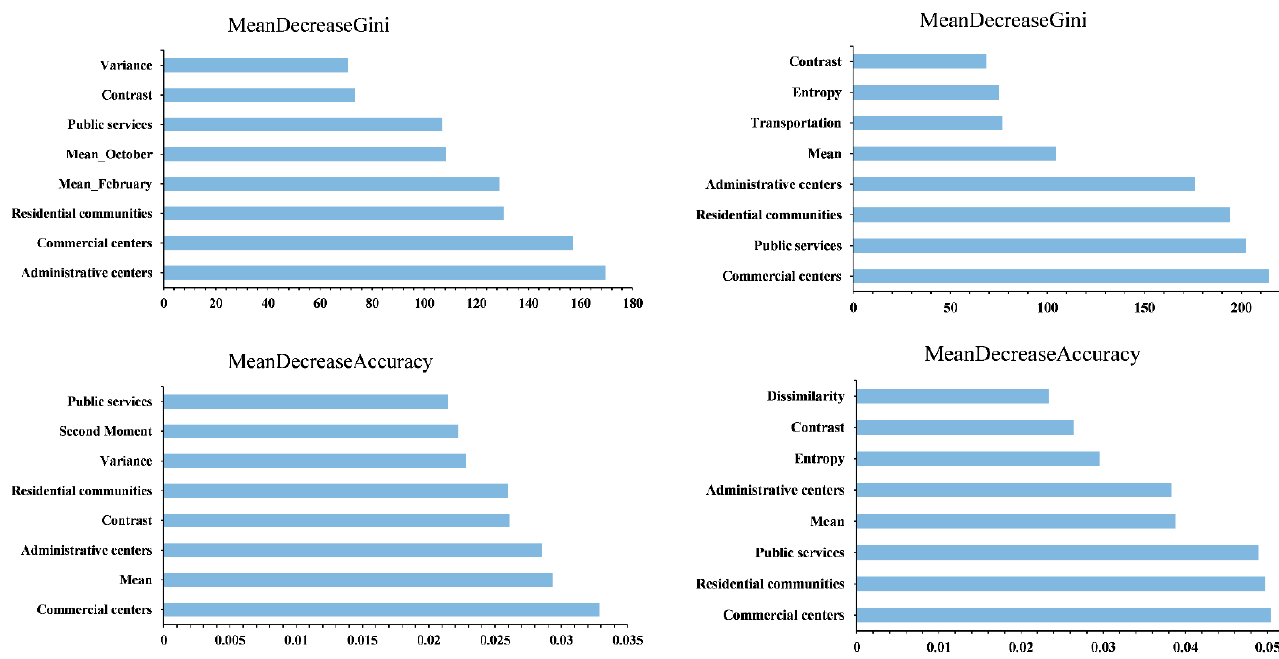
Figure 10. Contributions of different features. The ( left ) panel shows the feature contributions of Level I feature classification. The ( right ) figure shows the contributions of features for Level II feature classification.